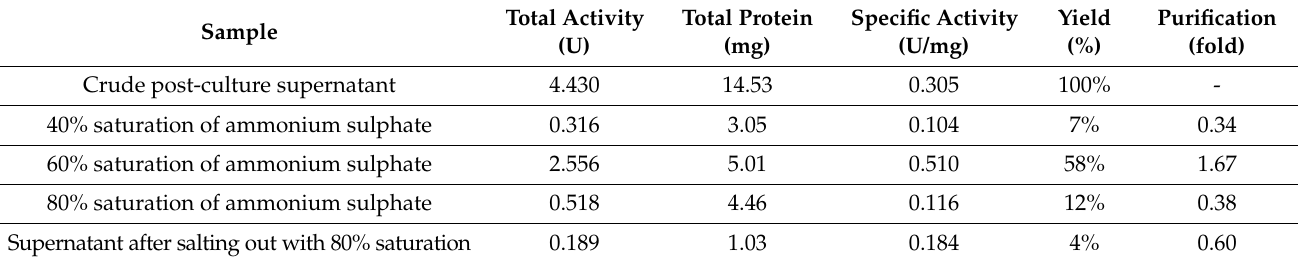
Table 2. Fractionated salting out of laccase K. bupleuri